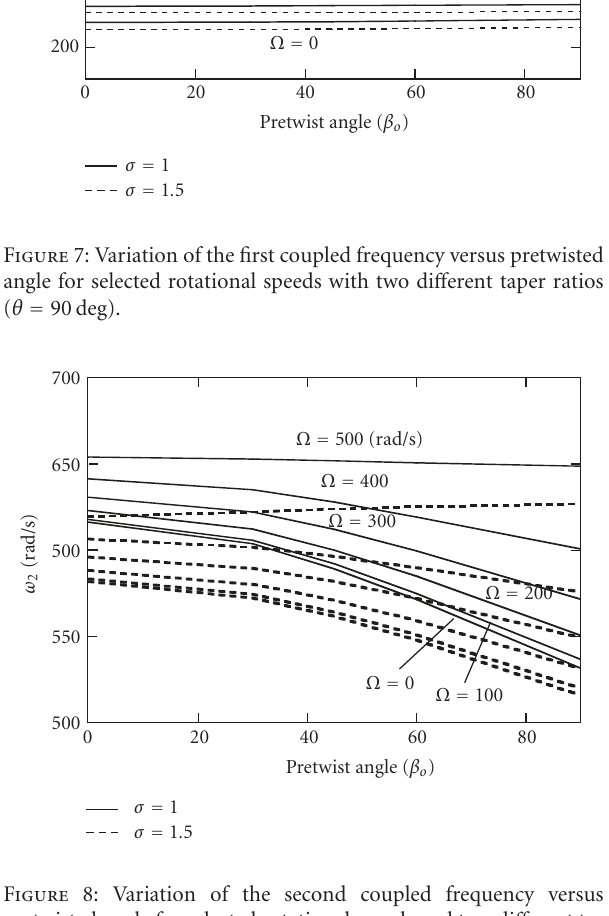
Figure 6: Variation of the third coupled flapping-lagging frequency versus plyangle for selected rotating speeds, and three di ff erent taper ratios ( γ = β = 0).